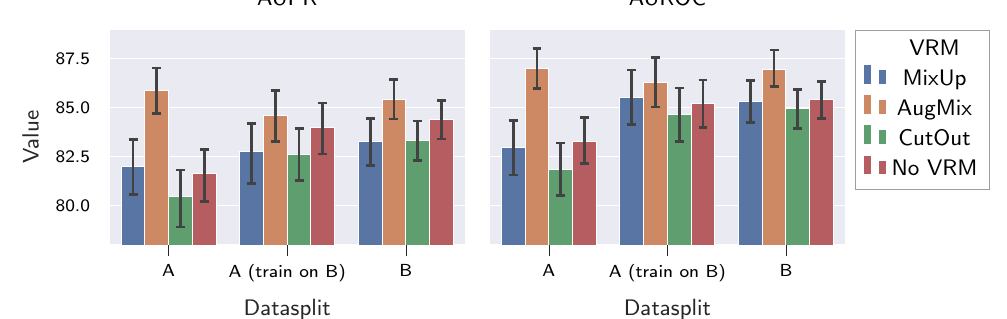
Figure 8. Influence of dataset composition and VRM type on the performance of supervised fabric AD methods on unseen fabrics. We show both mean and 95% CI for the AUPR and the AUROC achieved on the unseen fabrics by a pre-trained EfficientNet-B0 fine-tuned with the HSC